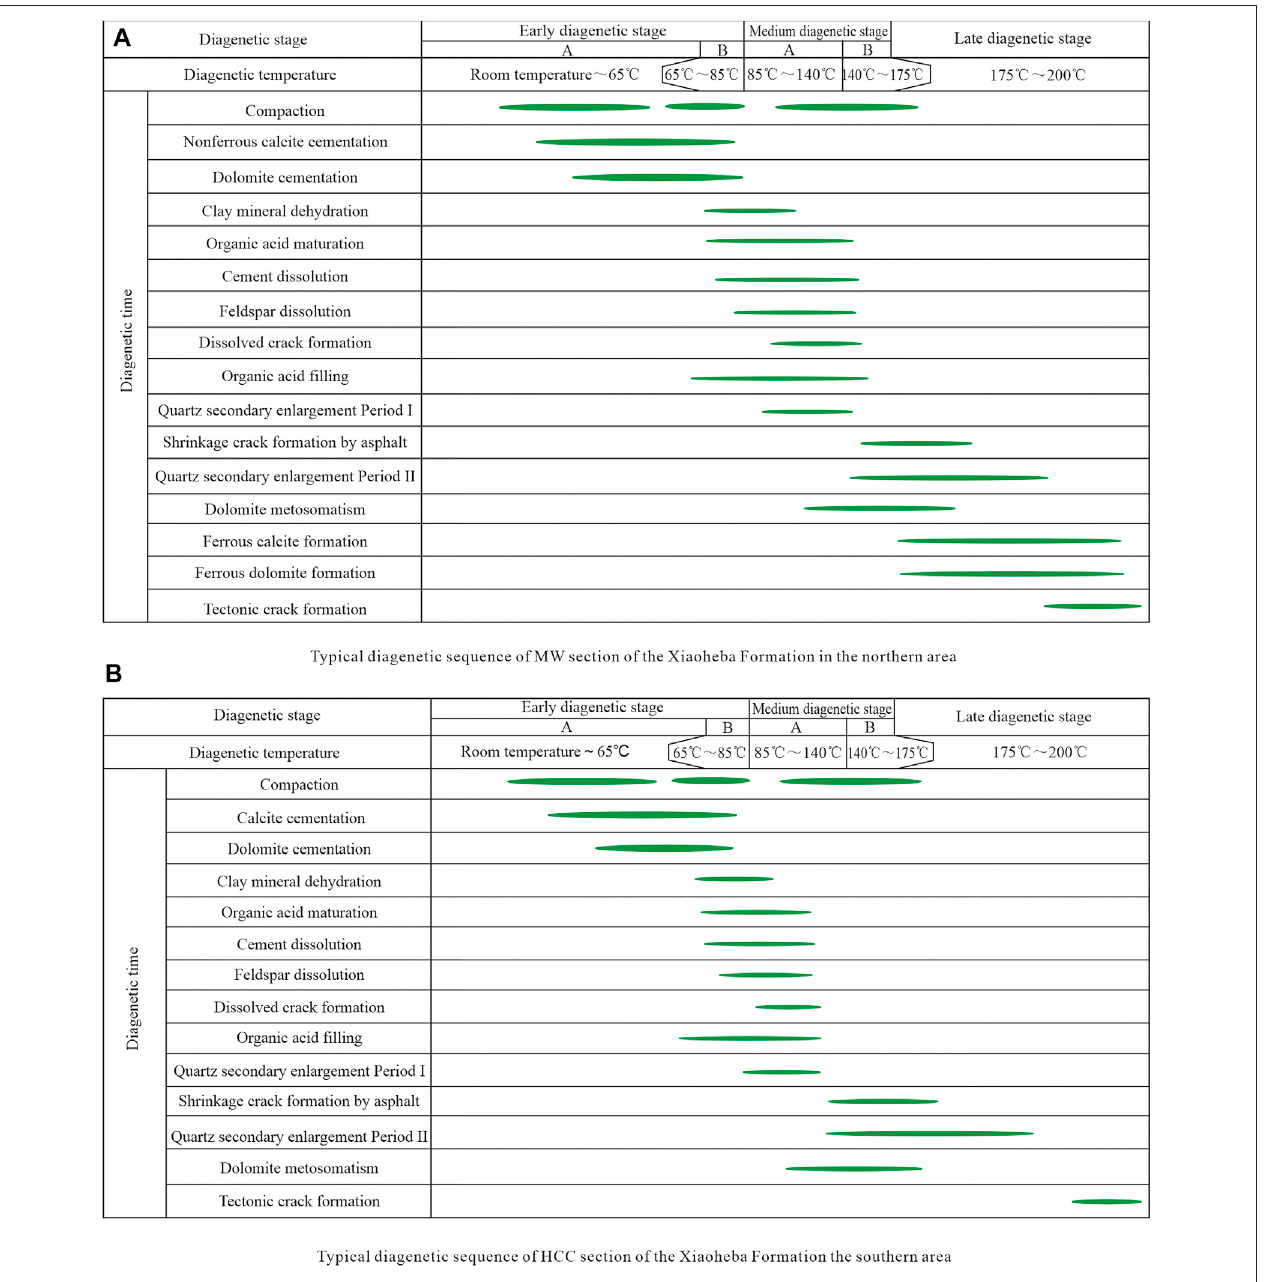
FIGURE 12 | Diagenetic stage classi fi cation of the Xiaoheba Formation in Southeast Sichuan; (A) Typical diagenetic sequence of the MW section of the Xiaoheba Formation in the northern area; (B) Typical diagenetic sequence of the HCC section of the Xiaoheba Formation the southern area